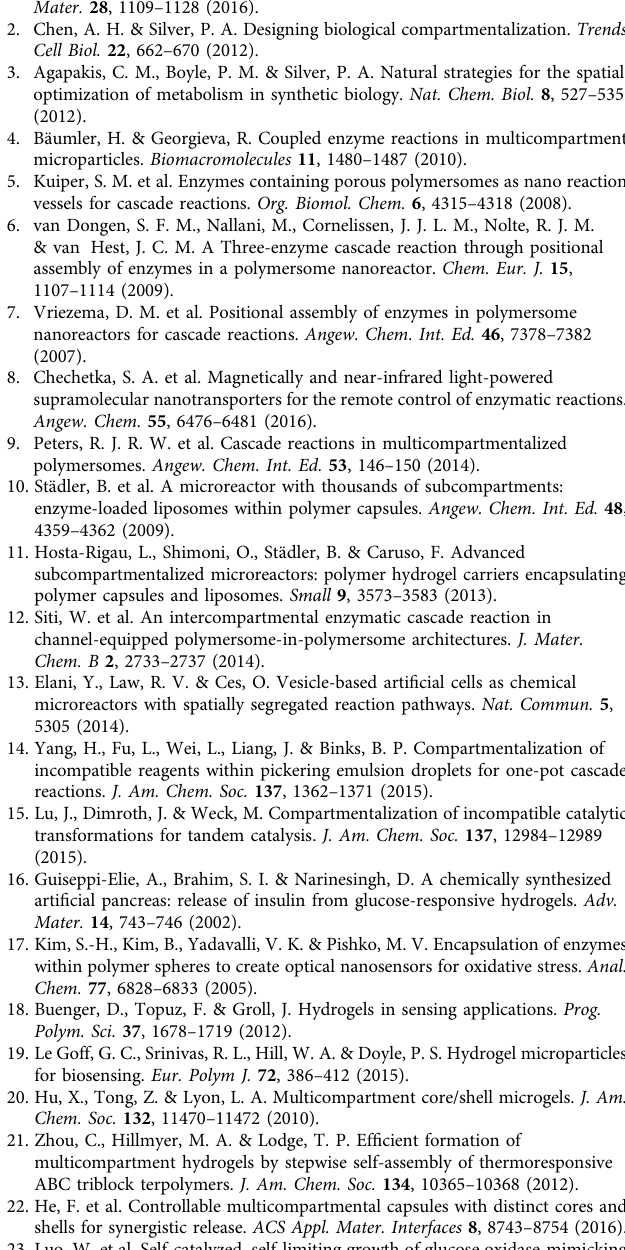
Fig. 1a. Typically, the fabrication procedure began with the formation of gel particles as the inner compartments originating from the gelation of droplets generated from the T 1# chip. Subsequently, the as-formed gel particles fl owed into the T 3# chip and further fused with other droplets generated from T 2# (outer compartment), forming hydrogel particles containing two different compartments after treatment with ultraviolet (UV) radiation. Silicon oil without surfactants was used as the continuous phase. A UV fi lter (OmniCure S1500) was used to provide the desired excitation for polymerization. The fl ow rates of the dispersed and continuous phases were 2 and 20 μ l min − 1 , respectively. Notably, this fabrication method is universal. Multi-compartmental hydrogel particles con fi ning different contents in distinct components can be easily obtained by choosing different pre-gel